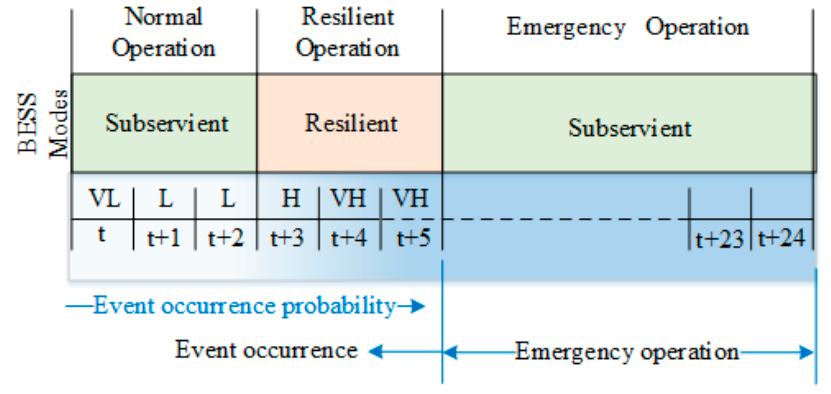
Figure 2. Battery energy storage system (BESS) operation modes and event occurrence probability.